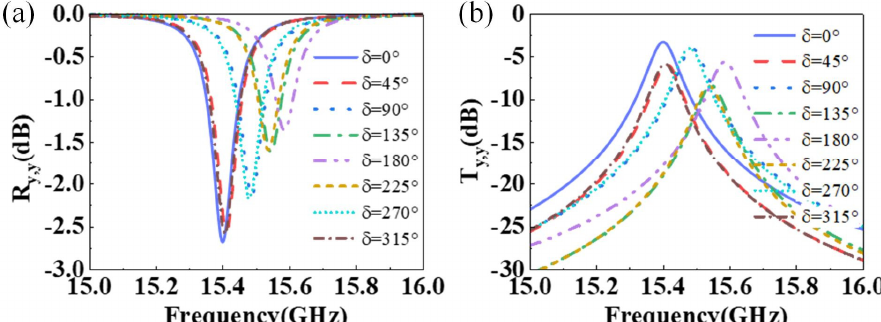
Figure 4. Reflection and transmission characteristics of the meta-surface under the illumination of the y-polarized EM wave. ( a ) Reflection amplitude and ( b ) Transmittance amplitude with different oriented C-shape meta-atoms at 15–16 GHz, where R y , y and T y , y refer to the transmission coefficients of the y-polarized component.